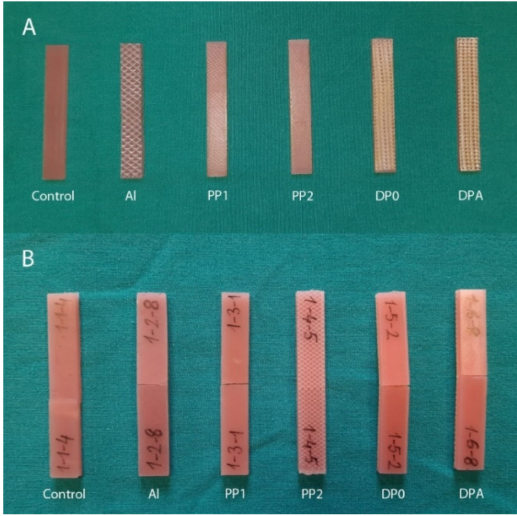
Figure 1. Test specimens before ( A ) and after the three-point bending test ( B ).